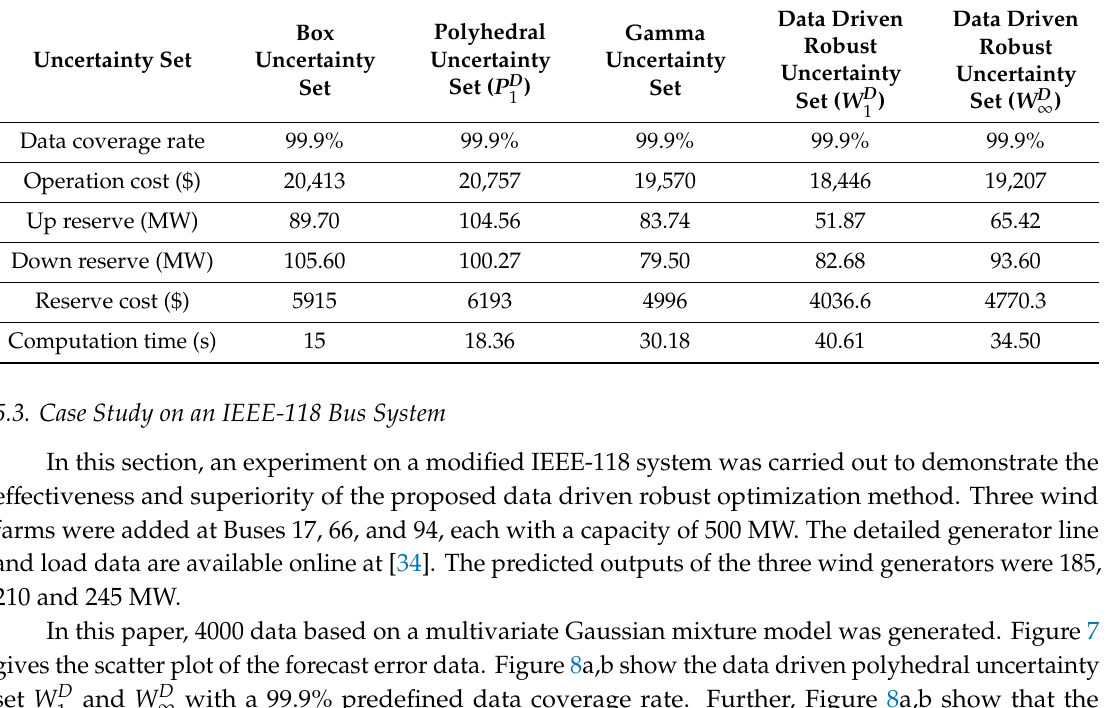
( d ) Figure 8. ( a ) Data driven polyhedral uncertainty set